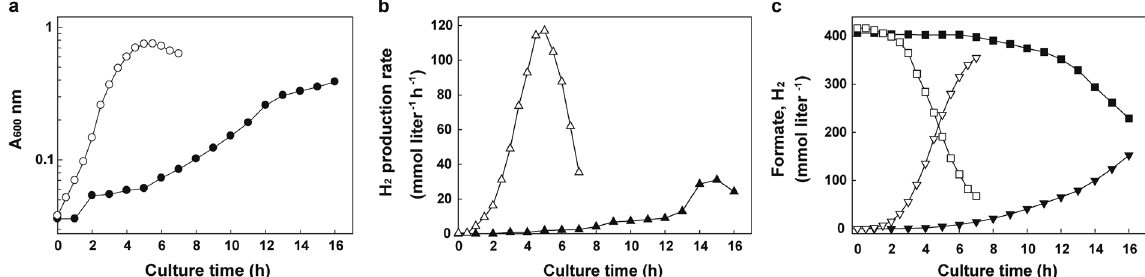
Figure 2. Time profiles of physiological changes in the parent and WTF-156T strains. Cell density (log A 600 nm ) ( a ) and H 2 production rate ( b ) in the parent (closed symbol) and WTF-156T (open symbol) strains. ( c ), Changes of formate (square) and hydrogen concentrations (inverted triangle) in the parent (closed symbol) and WTF-156T (open symbol) strains during the batch culture on 400 mM sodium formate. The pH was adjusted to 6.1–6.2 using 2 N HCl containing 3.5% NaCl as a pH-adjusting agent.